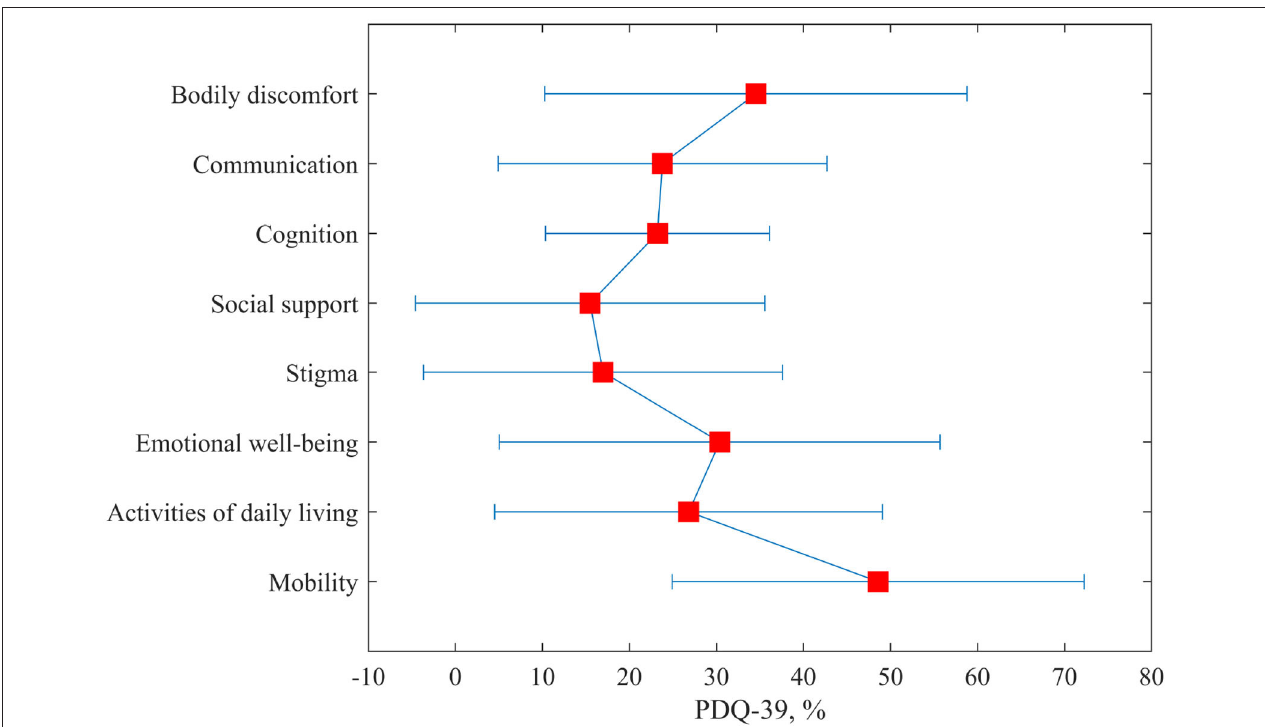
FIGURE 5 | The outcomes of the Parkinson’s Disease Questionnaire (PDQ-39) for the home group only.